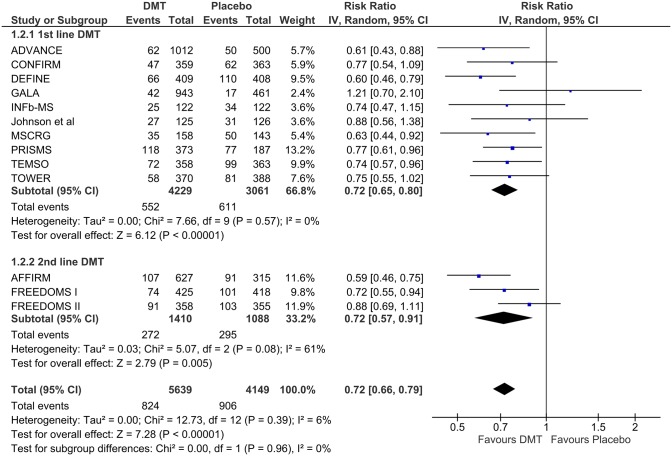
Subgroup analysis according to the current categorization of eligible disease modifying therapies as “first line” and “second line” drug options for the treatment of relapsing-remitting multiple sclerosis.